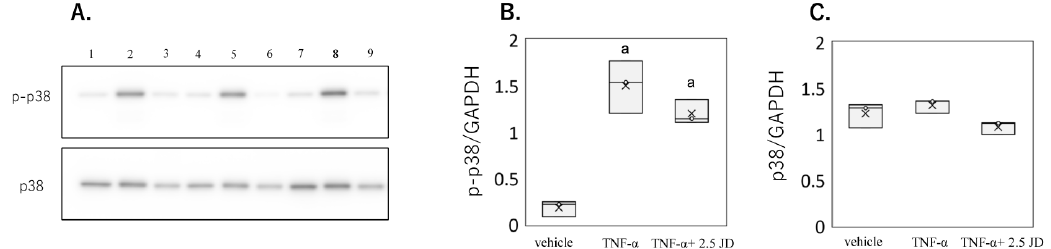
Figure 6. Effect of jietacin derivative on the p38 pathway in SW982. Western blotting for p38, phosphorylated p38 (p-p38), and GAPDH ( A ). Densitometry of Western blot protein bands for p-p38 ( B ) and p38 ( C ) were normalized to the expression of GAPDH ( n = 3). Vehicle, Lane 1,6,11; TNF- α , Lane 2,7,12; TNF- α + 2.5 JD, Lane 3,8,13; TNF- α + 1.25 JD, Lane 4,9,14; TNF- α + 0.625 JD, Lane 5,10,15. a p < 0.05 in comparison with vehicle.